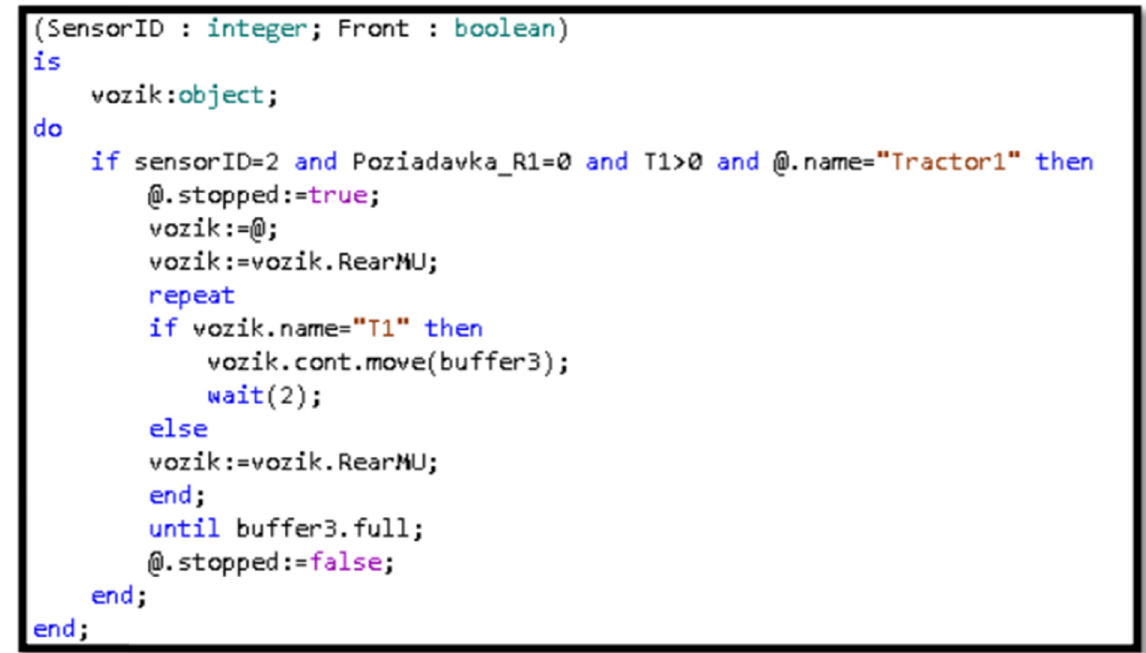
Figure 9: Created program sequence of the process of unloading of a logistics